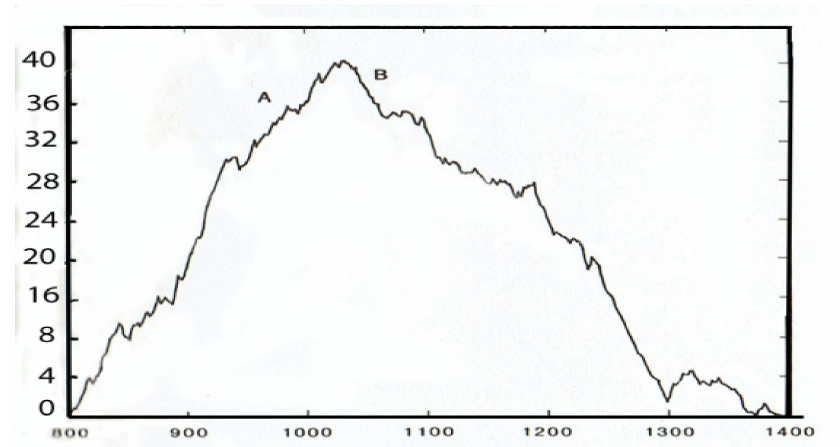
Figure 16. In the time period AD 800–1400, the 9 year moving average of Huascaran Mountain ice core yearly deposit layer thickness begins a decline indicating the start of extended severe drought conditions. Ordinate scale is in centimeters